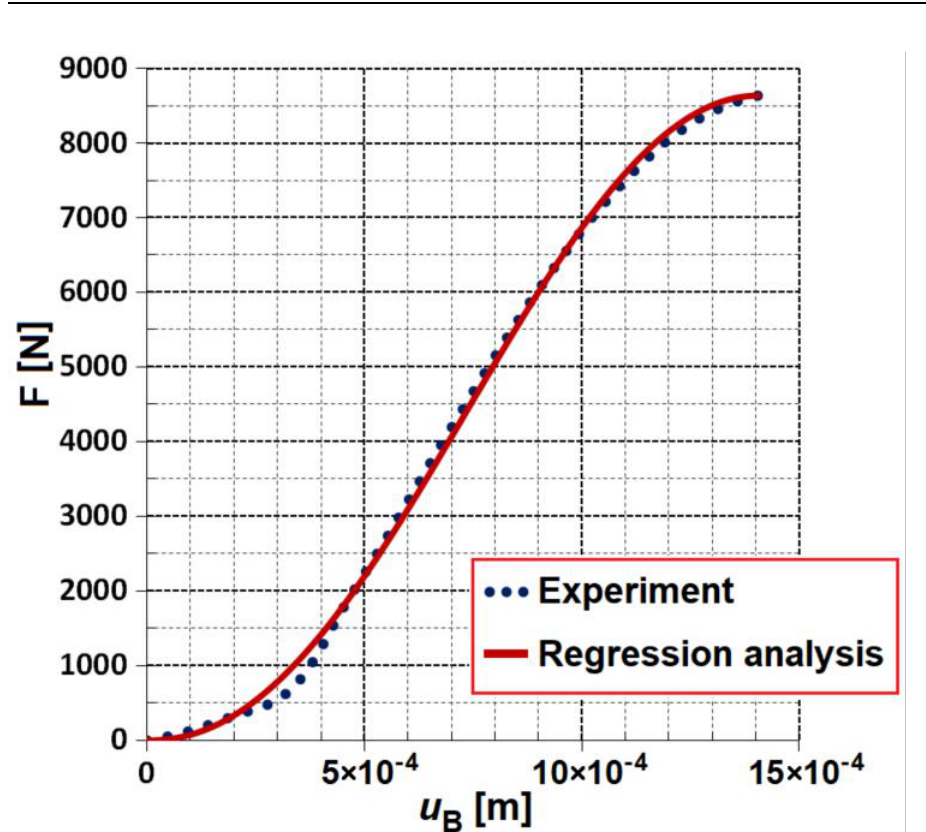
Figure 8. Pull-out test, measurement No. 1: Dependence of tensile force F on screw elongation u B (the experiment and its approximation by regression function F = N B = F E interval u B ∈ (cid:104) 0; u E (cid:105)